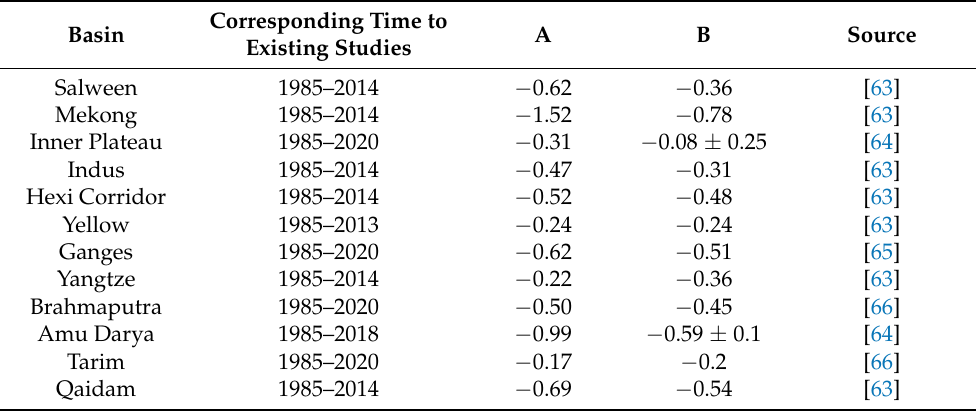
Table 6. Comparison of the change rate of clean glaciers between this study and existing studies. A: average annual rate of change for this study (% yr − 1 ). B: average annual rate of change of studies available (% yr − 1 ). Corresponding Time to A B Basin Existing Studies